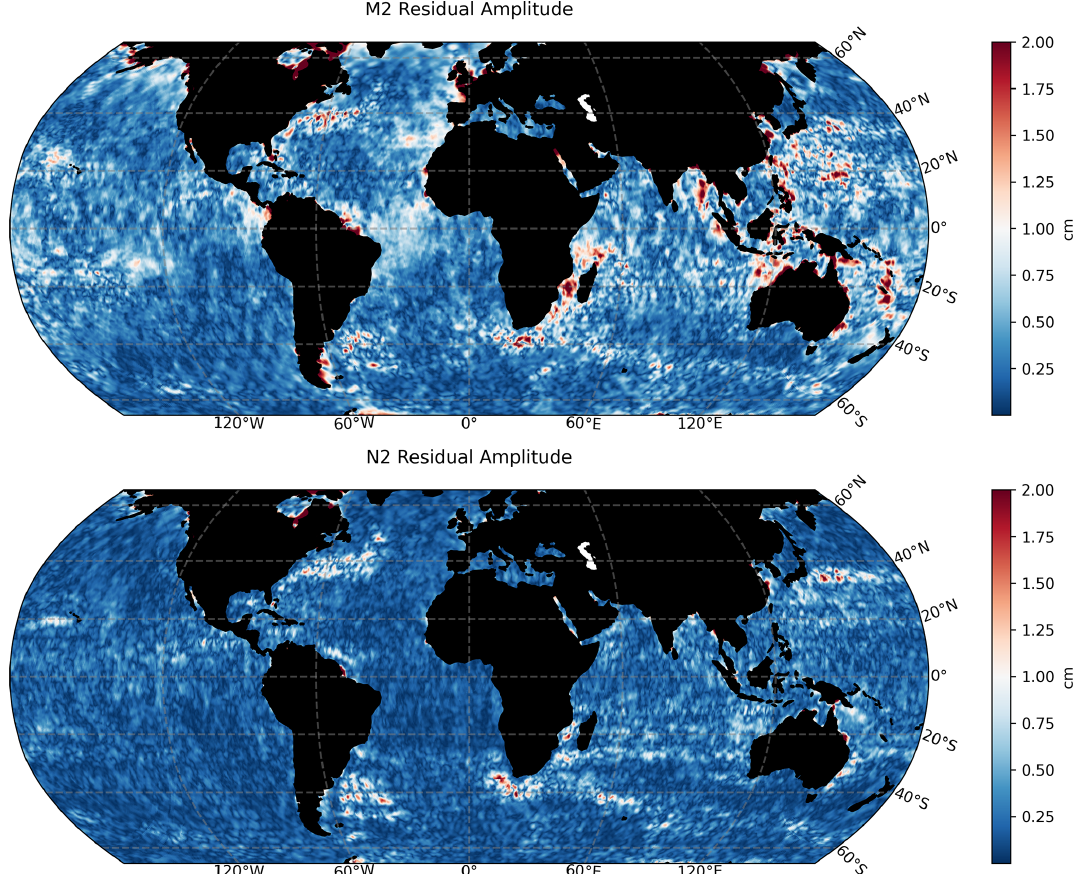
Figure 1. Maps of the residual amplitudes of the M2 and N2 tidal constituents as estimated by residual tidal